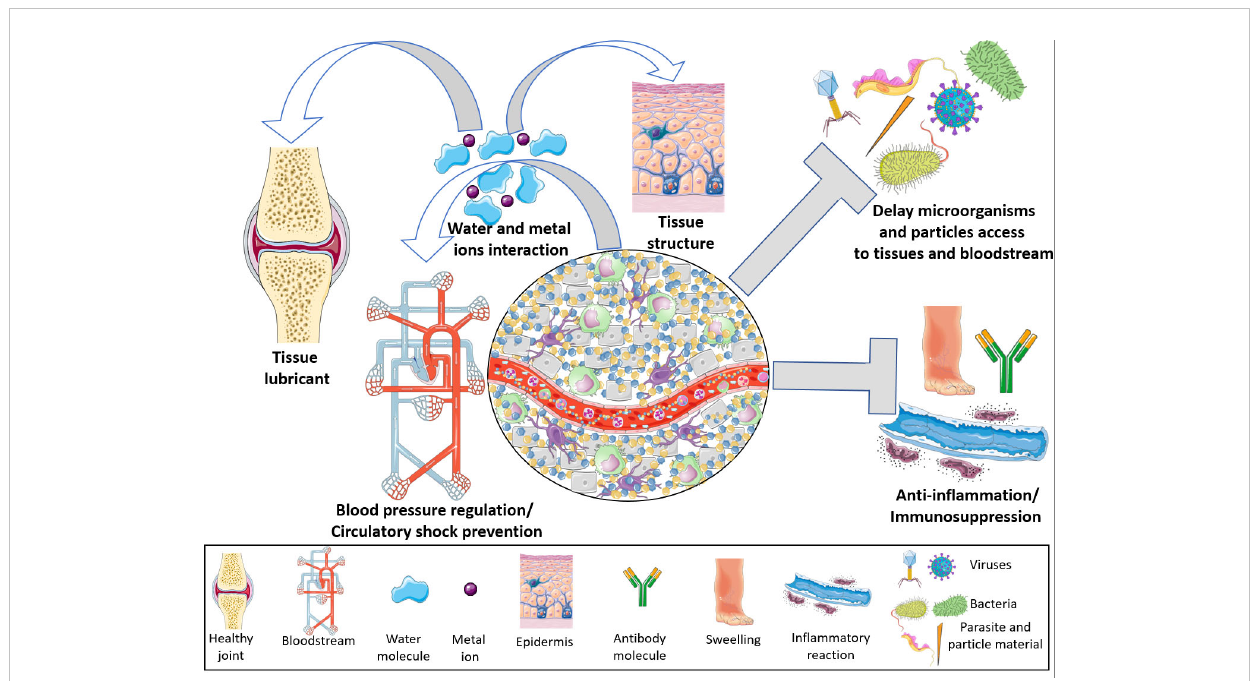
FIGURE 2 Hyaluronan physiological properties. On its high molecular weight form, hyaluronan is able to control a multitude of body functions. By interacting with high amounts of water and ions, hyaluronan becomes a potent regulator of the blood volume, thus controlling blood pressure and preventing a circulatory shock. Additionally, taking into account its chemical interactions, high molecular weight hyaluronan lubricates several tissues dampening physical friction, as well as contributing for the maintenance of tissues architecture. By interacting with water and extracellular matrix molecules, hyaluronan forms a mash which delays viruses, bacteria, parasites and material particles penetration into tissues and bloodstream. High molecular weight hyaluronan polymers are potent immunomodulators. These molecules abrogate innate and adaptive immune responses by blocking Toll Like Receptors or sequestrating cytokines and growth factors. This Figure was partly generated using Servier Medical Art, provided by Servier, licensed under a Creative Commons Attribution 3.0 unported license. Of note, some icons in this fi gure were adapted for our